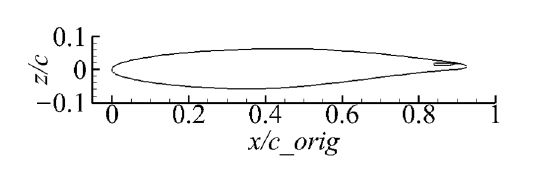
Figure 7. RAE2822 airfoil with Coanda surface.